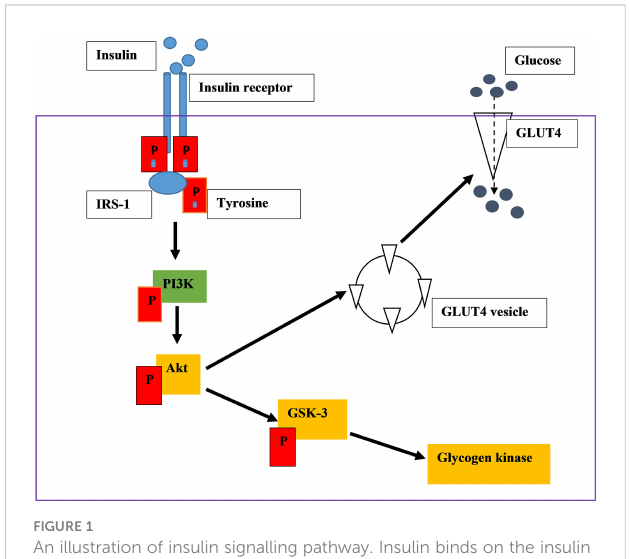
FIGURE 1 An illustration of insulin signalling pathway. Insulin binds on the insulin receptor extracellularly. The binding activates tyrosine kinase, leads into the phosphorylation of downstream kinases, ultimately stimulating GLUT 4 translocation which absorb